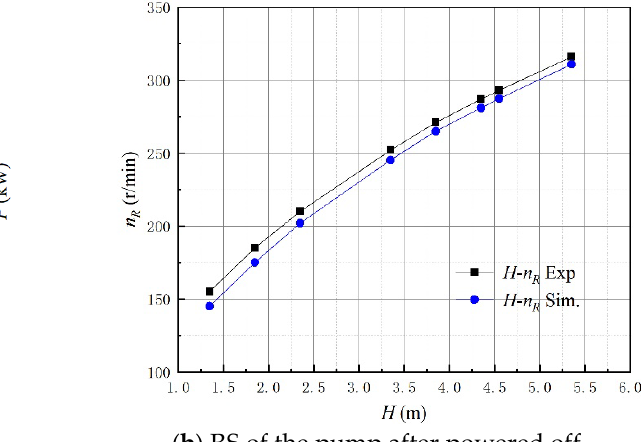
Figure 8. Comparison of the experimental results and simulation results.